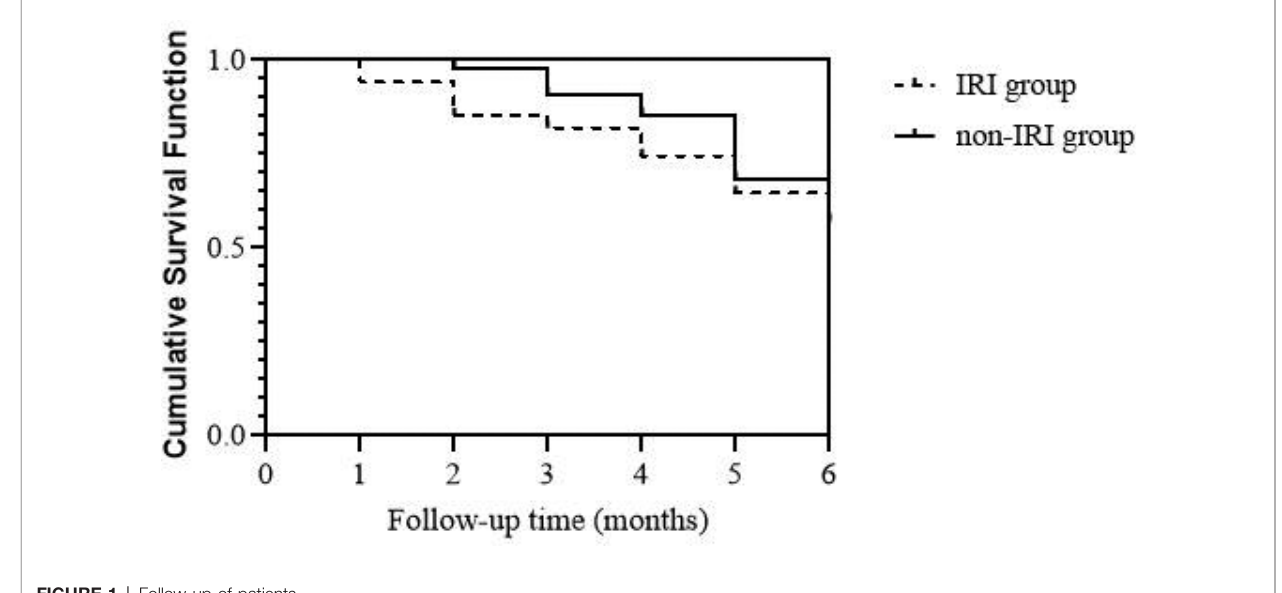
FIGURE 1 | Follow-up of